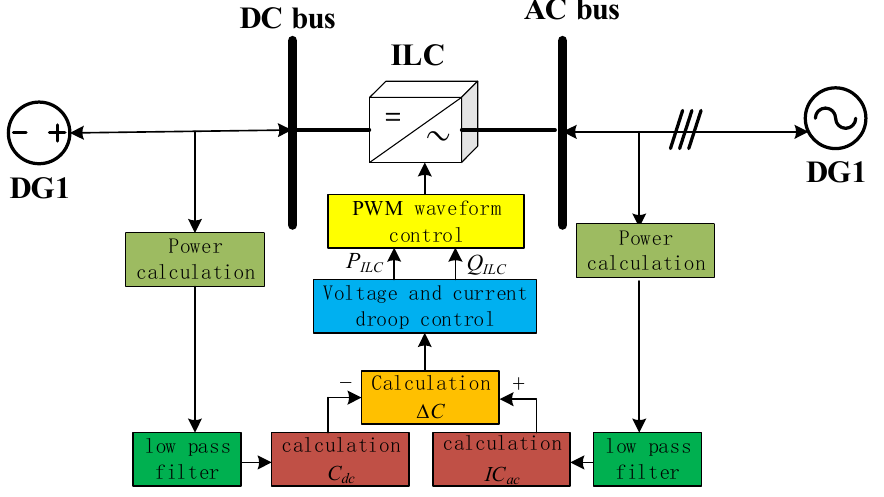
Figure 5. Control structure diagram between hybrid microgrid groups.